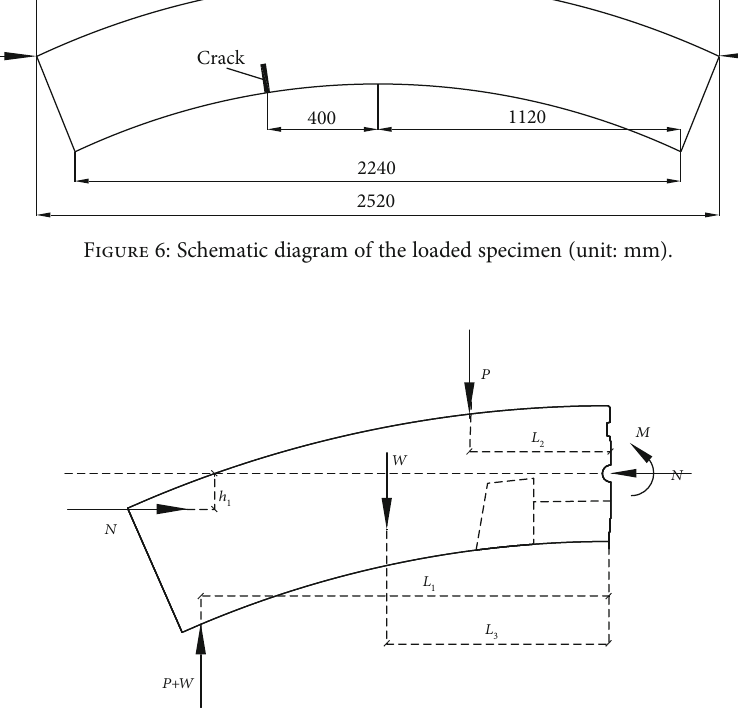
Figure 7: Force analysis of the loaded